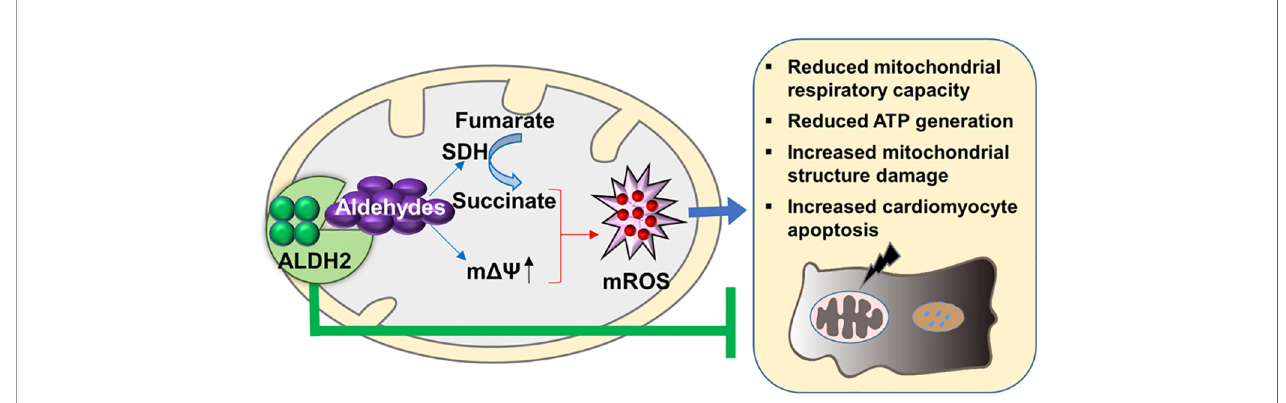
FIGURE 7 | The proposed molecular mechanisms of the protective effect of ALDH2 on post-cardiac arrest myocardial dysfunction. The aldehydes, e.g. 4-HNE, which are accumulated during ischemia/reperfusion result in mitochondrial ROS (mROS) burst. The latter triggers a series of orchestrated events including reduced mitochondrial respiratory capacity, reduced ATP generation, increased mitochondrial structure damage, and cardiomyocyte death, thereby contributing to myocardial dysfunction. Evidence from this study show that targeting ALDH2 would provide an important approach for treating post-cardiac arrest myocardial dysfunction through inhibiting mitochondrial ROS